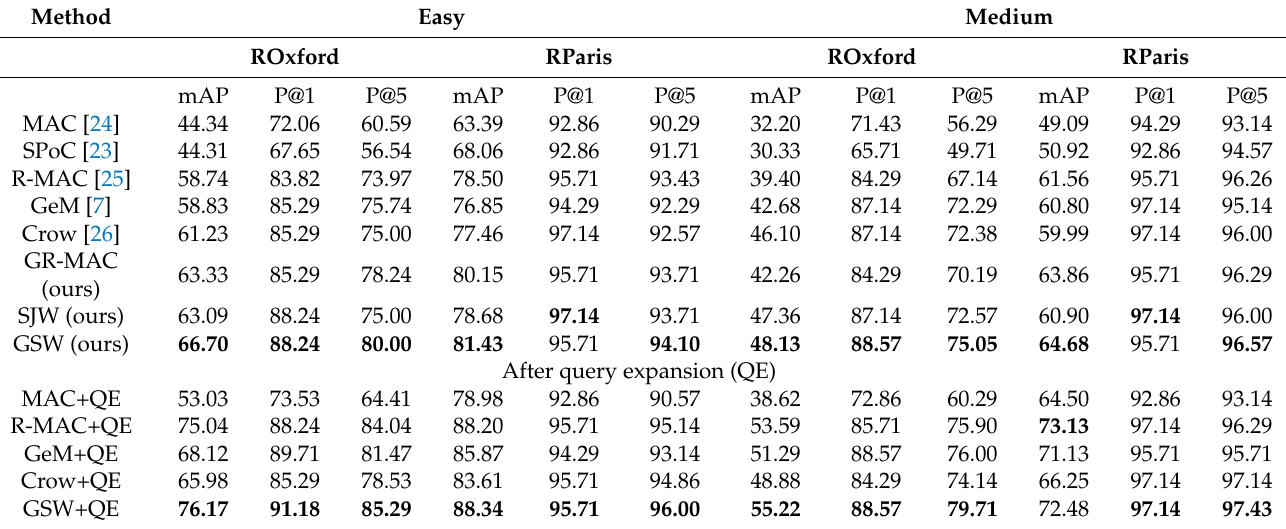
Table 7. Performance (mAP) comparison with the state-of-the-art algorithms on the ROxford and RParis data sets. Dim: dimensionality of the final compact image feature descriptors. QE: using query expansion (+QE). The best result is highlighted in bold.